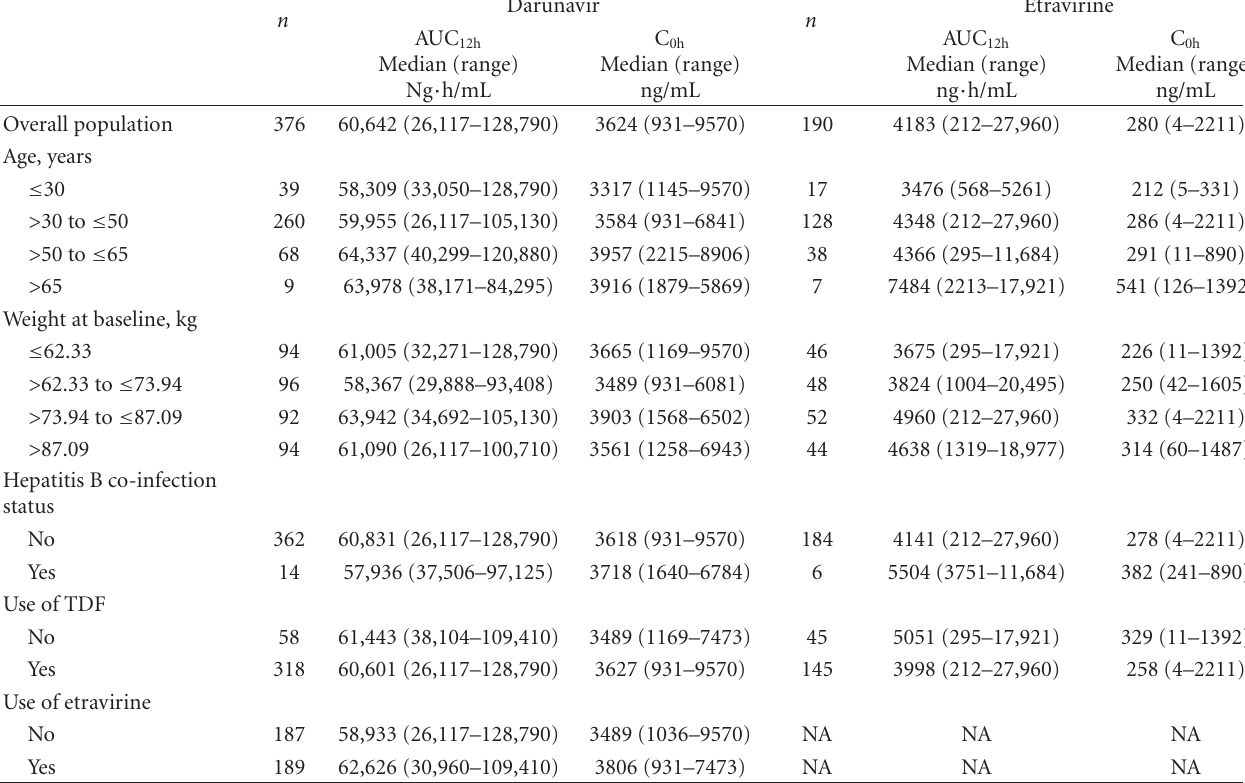
Table 2: Population pharmacokinetics at Week 48 (univariate analysis).